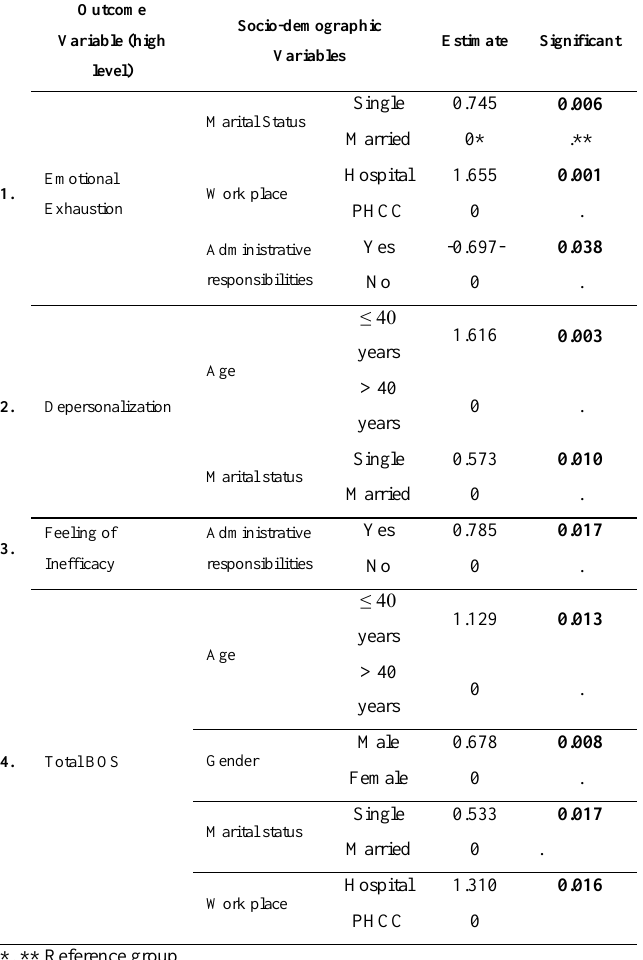
Table 3: Estimate of ordered log-odds and significant associations between socio-demographic variables and high level of the outcome variables according to ordinal logistic regression estimate: